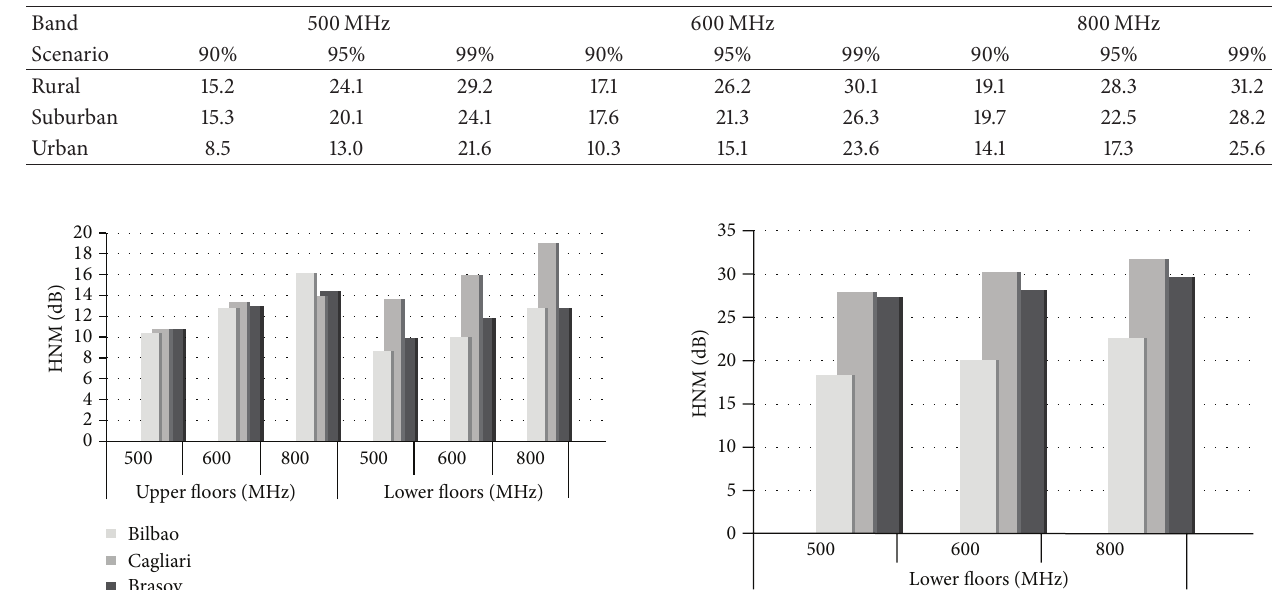
Table 4: Hidden node margin for % of locations in the three considered frequency bands.